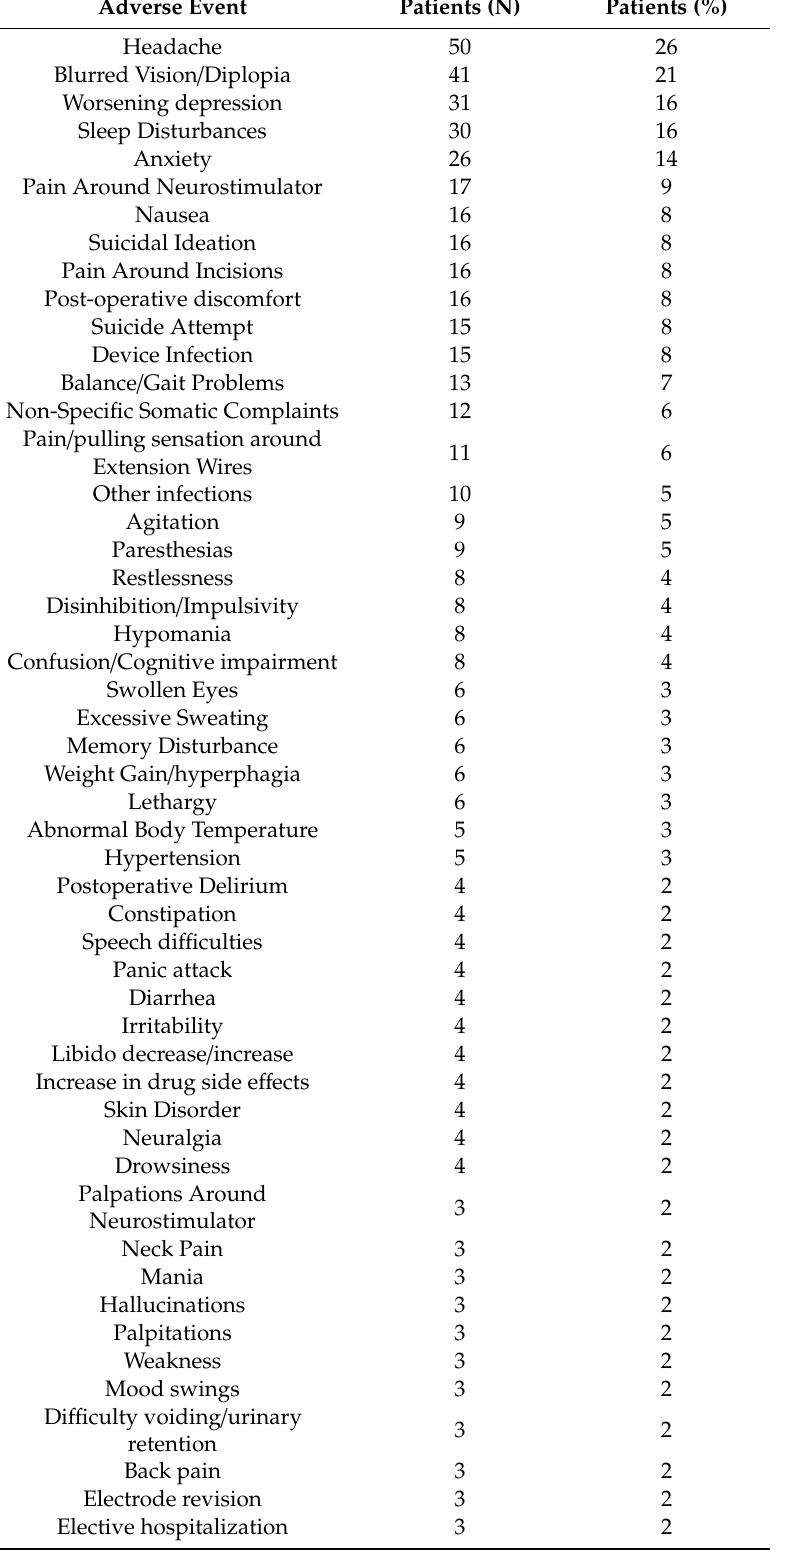
Table 2. Adverse